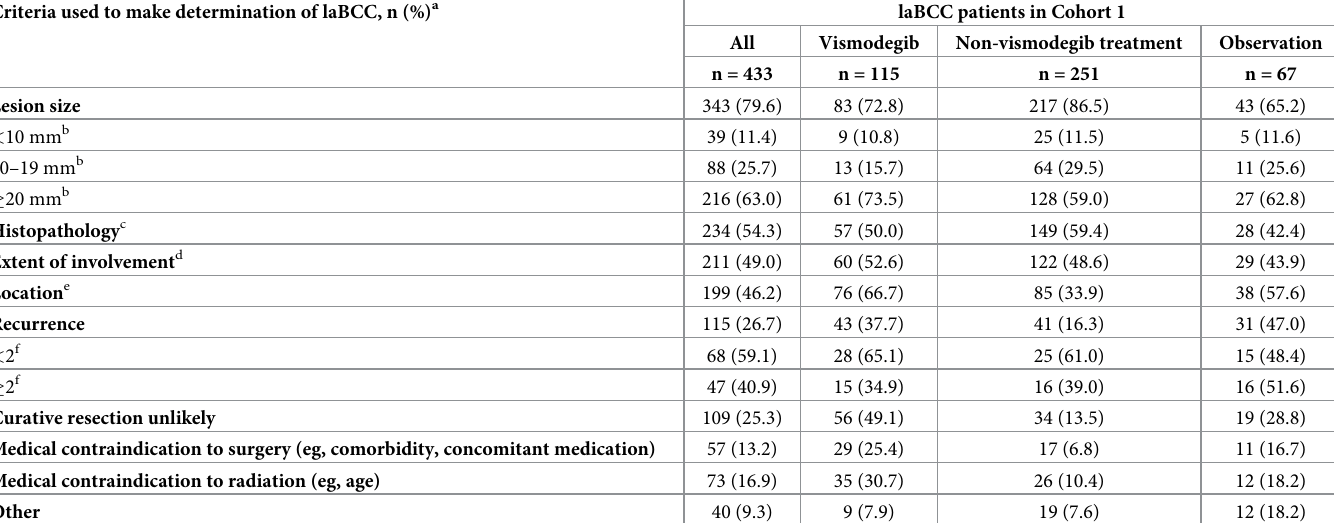
Table 2. Determination of locally advanced basal cell carcinoma in patients in Cohort 1. Criteria used to make determination of laBCC, n (%)